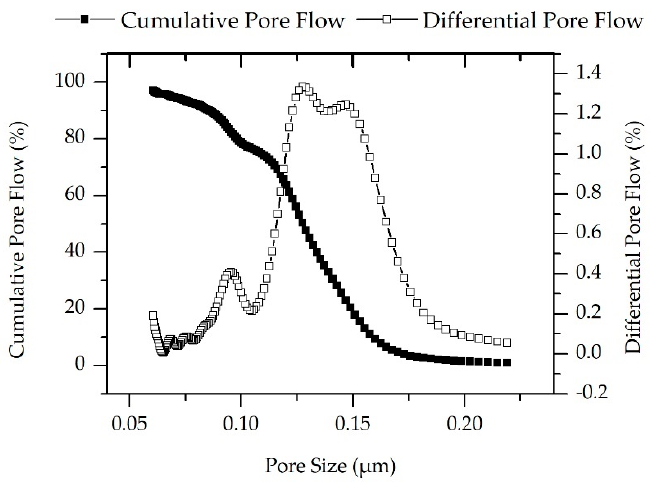
Figure 6. Pore size of the ceramic membrane as a function of the differential gas flow and cumulative gas flow through the pores, measured using capillary flow porometry.